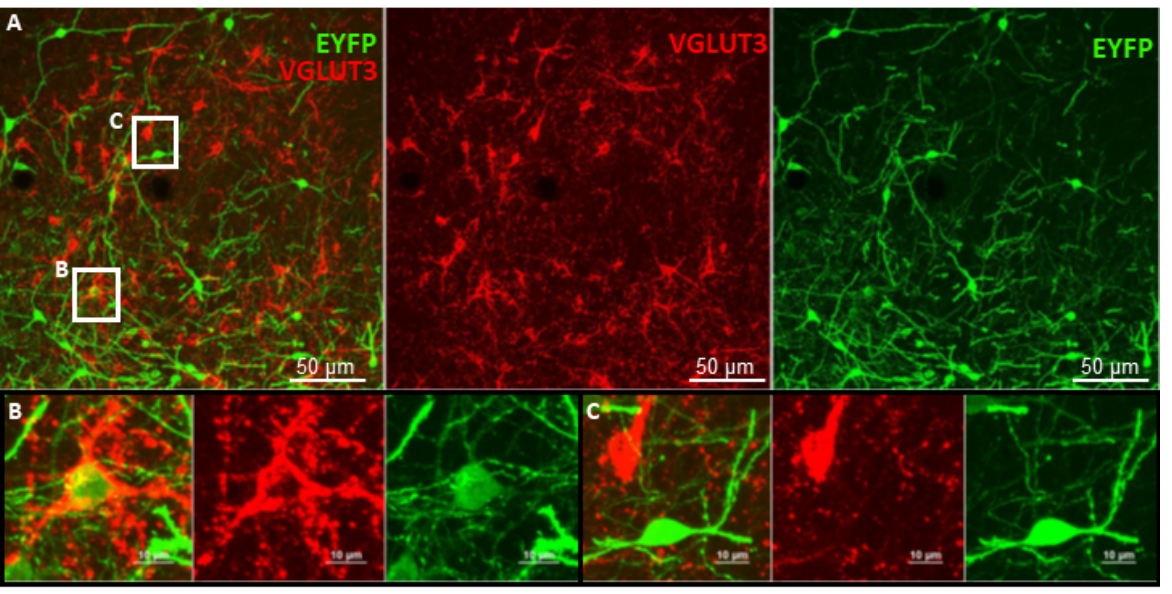
Figure 3. Improper functioning of Cre system in the BNST. ( A ) VGLUT3 ‐ Cre mouse acquired from the Jacksons Laboratory (USA; stock No.: #028534) and bred locally at the Institute of Experimental Medicine was injected with AAV containing the sequence of EYFP in a DIO construct (Addgene, catalog No.: #20298 ‐ AAV5) (see Figure 2B). Brain slices of 30 μ m thickness were stained with a ‐ VGLUT3 (rabbit, Synaptic Systems, stock No.: #135203) and a ‐ EYFP (chicken, Life Technol ‐ ogies, stock No.: #A10262), then with Alexa ‐ 594 conjugated a ‐ rabbit (goat host, Life Technologies, stock No.: #A11012) and Alexa ‐ 488 conjugated a ‐ chicken (goat host, Life Technologies, stock No.: #A11039) antibodies, respectively. EYFP ‐ positive (green) cells represent Cre activity. ( B ) Example of a proper Cre system functioning: VGLUT3+ (red) neuron was able to inverse and express the gene sequence of EYFP that was coded in the injected AAV in the BNST. ( C ) Example of an im ‐ proper Cre system functioning: numerous other cells in the BNST that are VGLUT3+ (red) failed to express the EYFP, while VGLUT3 negative neurons were able. Thus, this VGLUT3 ‐ Cre mouse could not be used for the specific manipulation of BNST VGLUT3+ neurons. Double fluorescent immunohistochemistry was done by László Bíró, and the pictures were taken by him at the Nikon Centre at the Institute of Experimental Medicine with C2 confocal laser ‐ scanning microscope at 20× and 60× magnification. AAV: adeno ‐ associated viral vectors; BNST: bed nucleus of stria terminalis; DIO: double ‐ floxed inverted open reading frame; EYFP: enhanced yellow fluorescent protein; VGLUT3: vesicular glutamate transporter type 3.